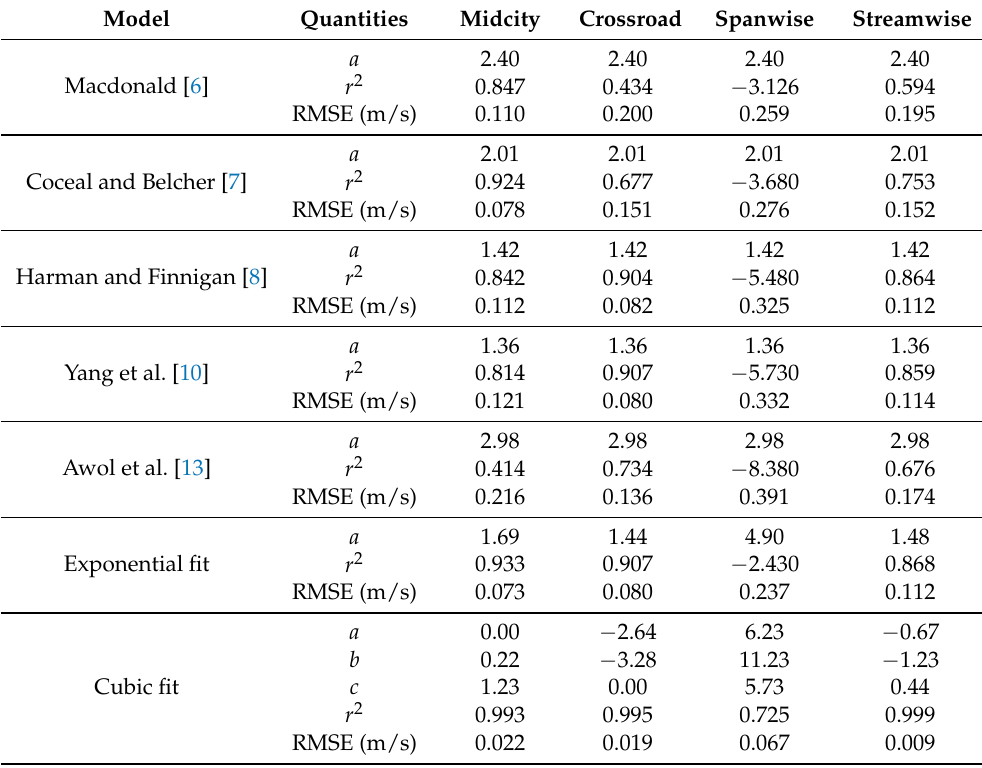
Table 5. Velocity results for case 13—curve fitting and legacy schemes.